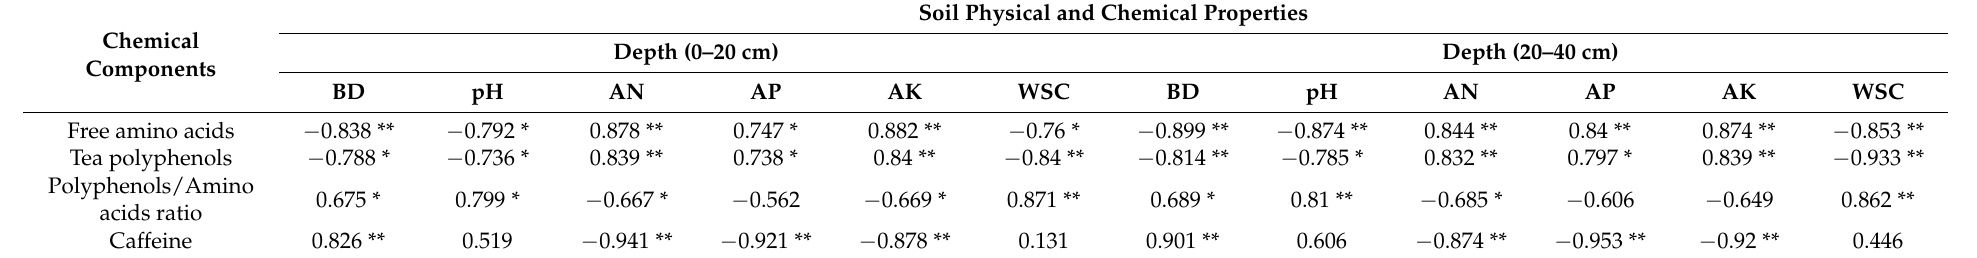
Table 3. Correlations of soil properties to the tea-leaves indicators in the three sampling